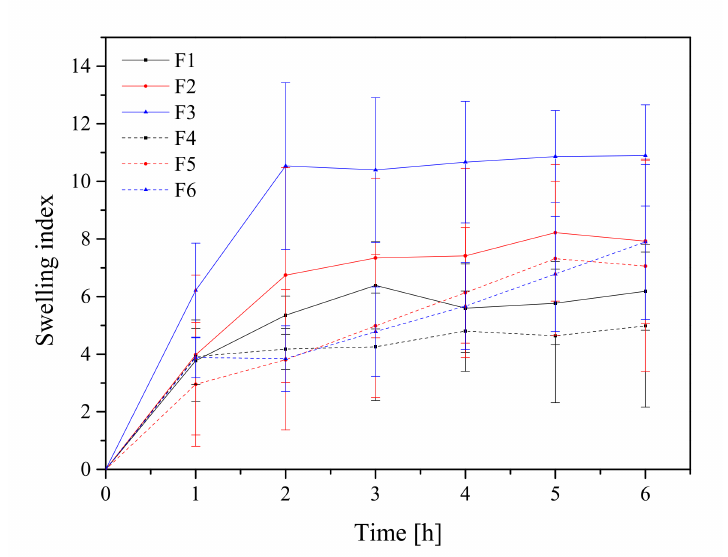
Figure 5. Swelling index study of formulations